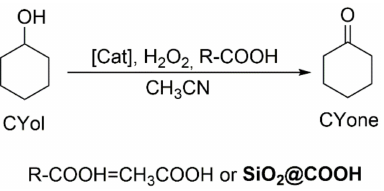
Figure 17. Catalytic oxidation of cyclohexanol.